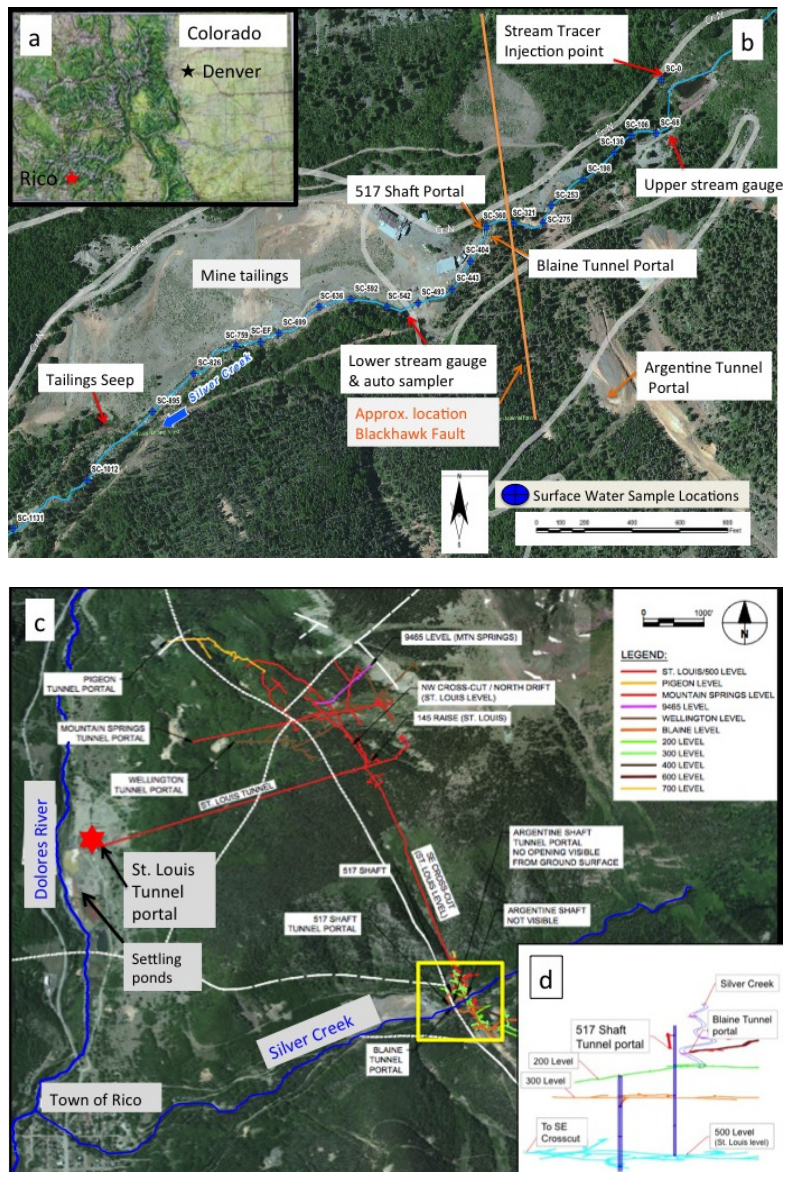
the shaft collar, which corresponds to the elevation of the SE Crosscut and St. Louis Tunnel. Water samples were collected from the shaft using a bailer and mechanical pulley system located at the collar. The final access point to sample mine water was the St. Louis Tunnel portal. The portal had collapsed preventing underground access so samples were collected at first emergence from the collapse. Figure 1. ( a ) Map of State of Colorado with location of Town of Rico located in the San Juan Mountains of southwestern Colorado; ( b ) Site map of Rico-Argentine mine complex and Silver Creek. Silver Creek sampling location numbers refer to the distance downstream (m) from the tracer injection point; ( c ) Overview map of entire Rico-Argentine mine complex in relation to the Town of Rico and the Dolores River. Yellow box shows location of mine complex and represents extent of figure 1b. Location and extent of the subsurface workings are overlain on top of aerial imagery to demonstrate how mine workings near Silver Creek are connected to the St. Louis Portal; ( d ) Vertical view of mine workings in relation to Silver Creek and access points. The 200 and 300 levels pass directly under Silver